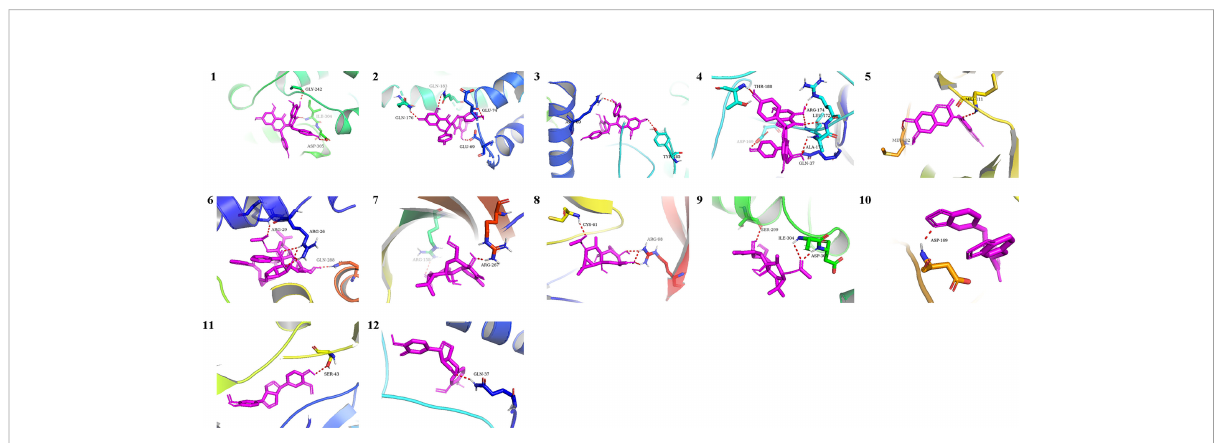
(Figure 10A). JC-1 is a fl uorescent probe used to detect mitochondrial membrane potential ( DY m). The decrease of DY m is a hallmark event in the early stages of apoptosis and related to ferroptosis. Compared with the control group, the green fl uorescence levels increased signi fi cantly after the A172